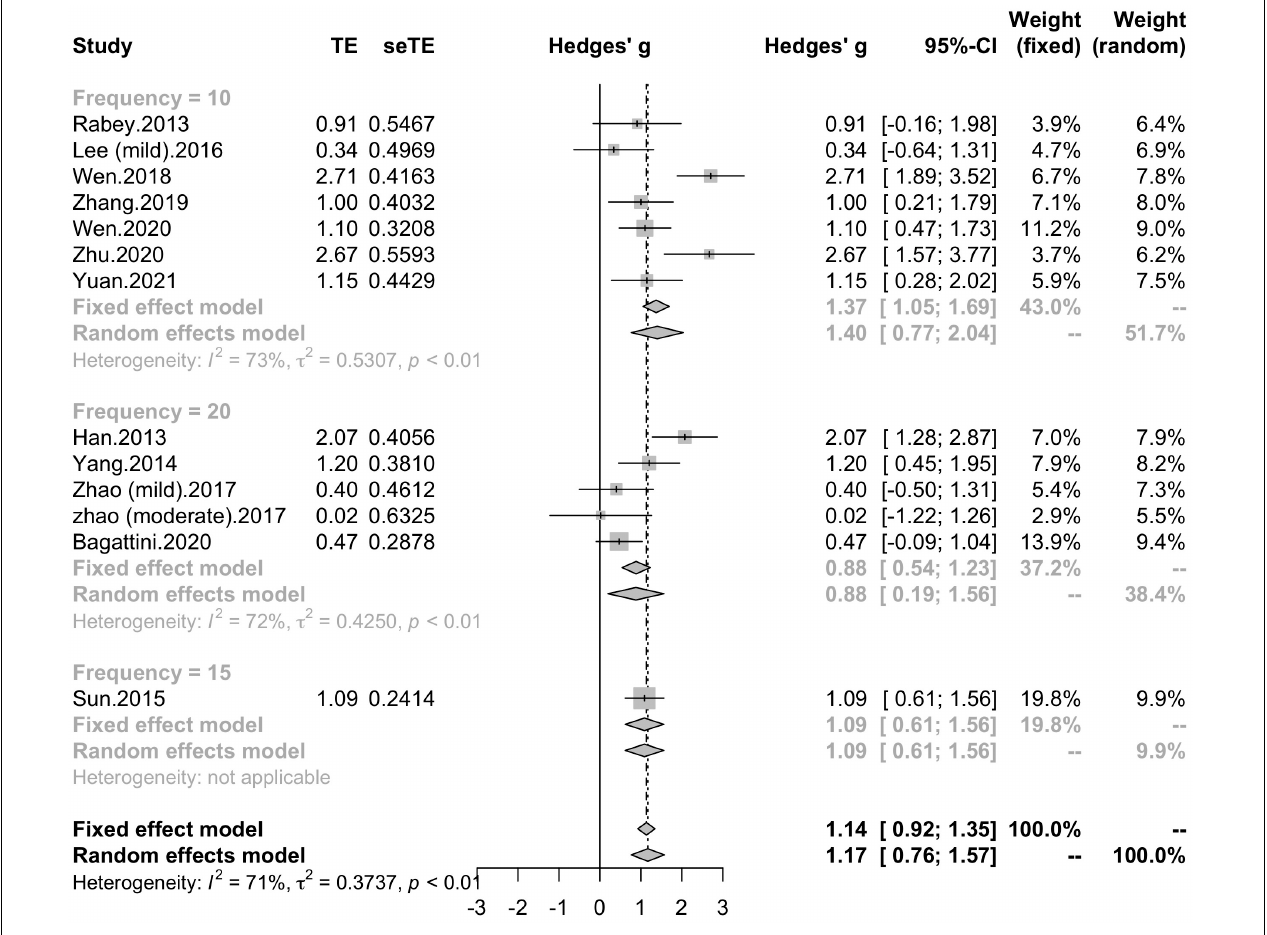
FIGURE 5 | Forest plot: mean differences in frequency subgroup with 95%